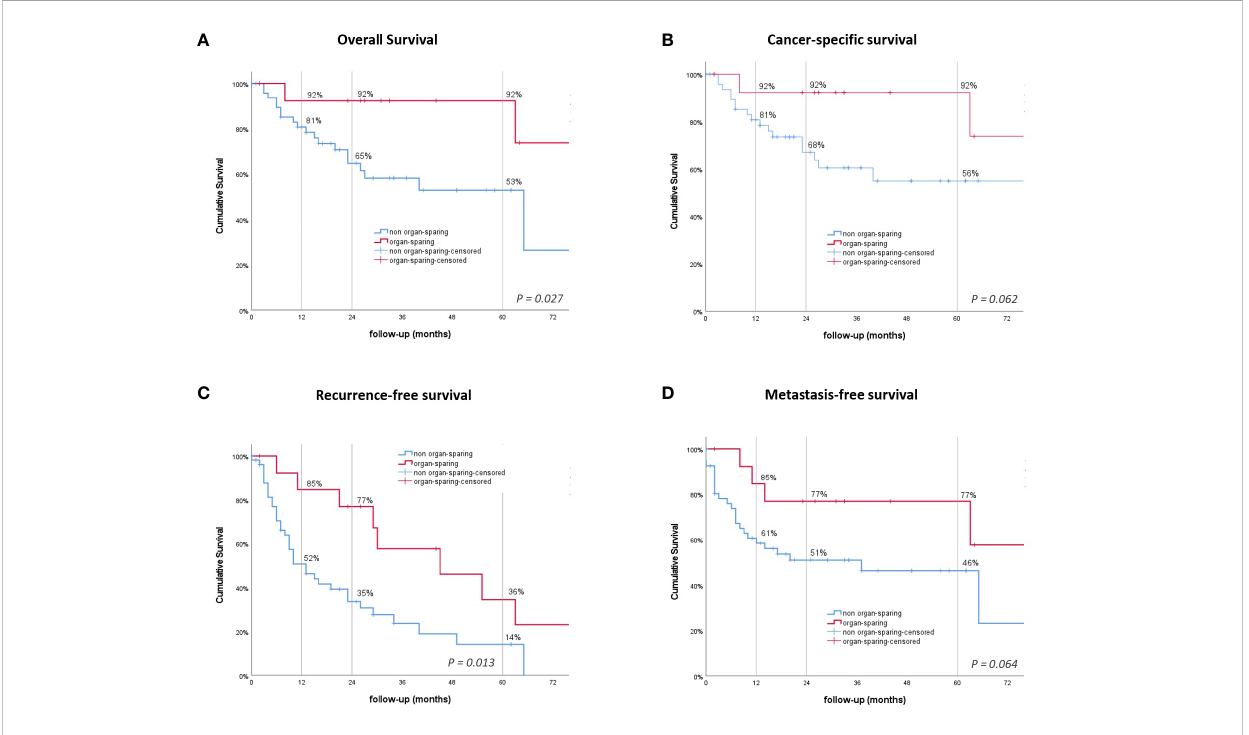
FIGURE 2 Kaplan – Meier survival curves. (A) Overall survival (OS). (B) Cancer-speci fi c survival. (C) Recurrence-free survival (RFS). (D) Metastasis-free survival. P- values by